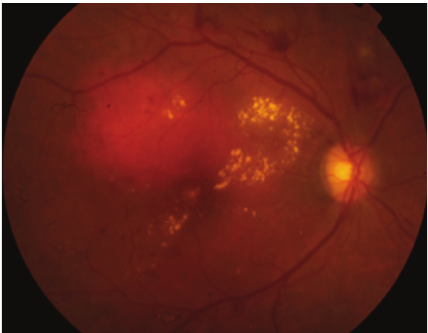
Figure 1: Diabetic retinopathy showing intraretinal hemorrhages, hard exudates, and microaneurysms in the posterior pole associated with diabetic macular